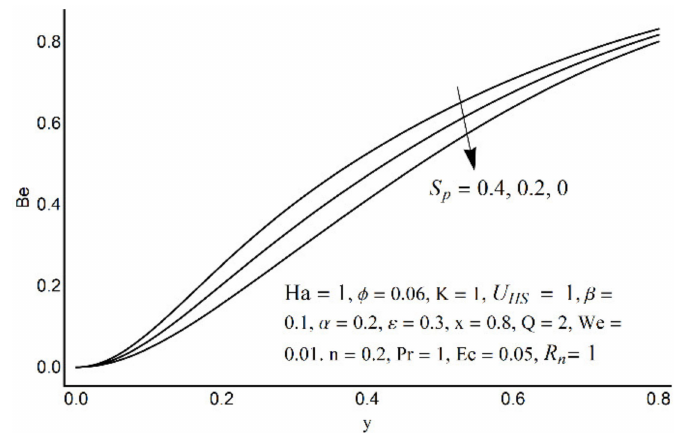
Figure 21. The Bejan number for different values of S p